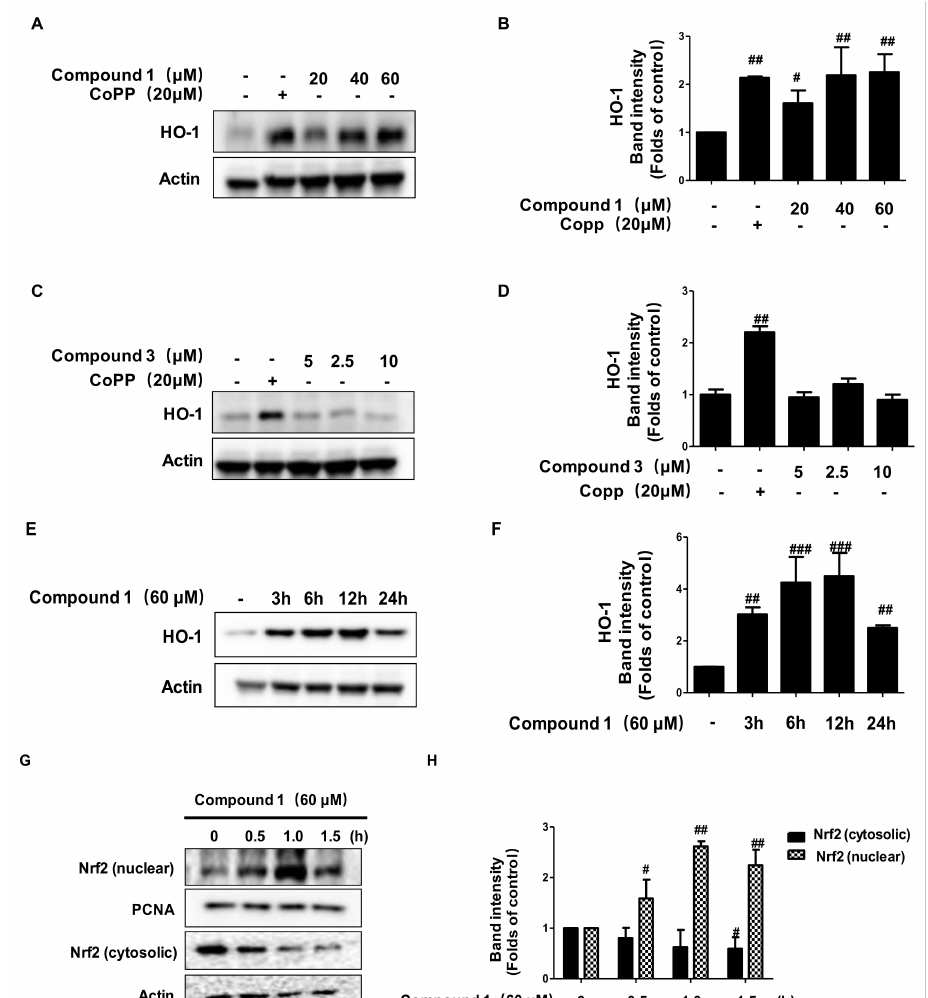
Figure 8. Effects of compounds 1 and 3 on heme oxygenase (HO)-1 expression and Nrf2 translocation. HaCaT cells were incubated for 12 h with the indicated concentration of compound 1 (20–60 µ M) and compound 3 (2.5–10 µ M) ( A – D ). HaCaT cells were incubated with 60 µ M of compound 1 for 0–24 h ( E , F ). HaCaT cells were treated with 60 µ M of compound 1 for 0.5, 1, and 1.5 h ( G , H ). The nuclei were fractionated and Western blot analyses for HO-1 and Nrf2 expression were performed. Data are represented as the mean ± SD of three independent experiments. # p < 0.05, ## p < 0.01, ### p < 0.001 vs.